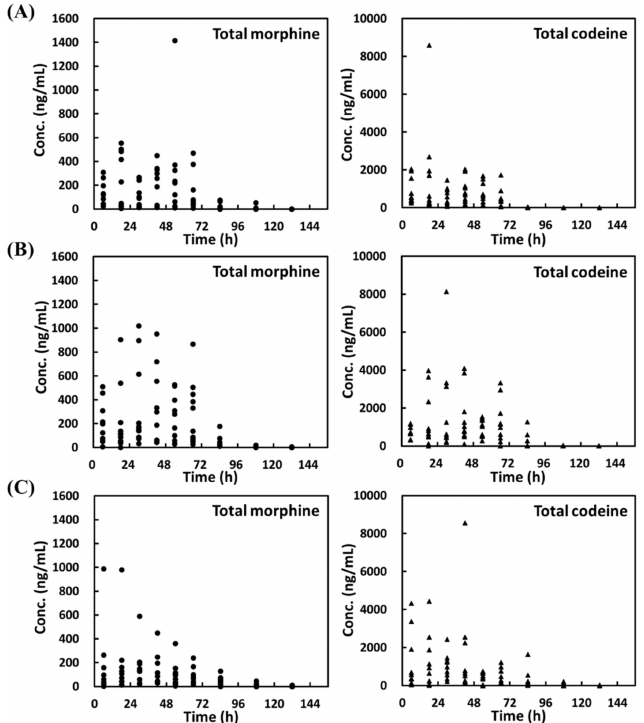
Figure 2. Total concentrations of morphine (left) and codeine (right) in the clinical urine samples from the ten participants collected at di ff erent times following oral administration of cold syrups based on the suggested use (4.8 or 5 mg codeine phosphate in each dose) described by the manufacturer ( A ) Consrine, ( B ) ssBuron, and ( C ) Pabron). Total morphine refers to the total concentration of morphine calculated from the free form of morphine, M3G, and M6G in the urine. Total codeine refers to the total concentration of codeine calculated from the free form of codeine and C6G in the